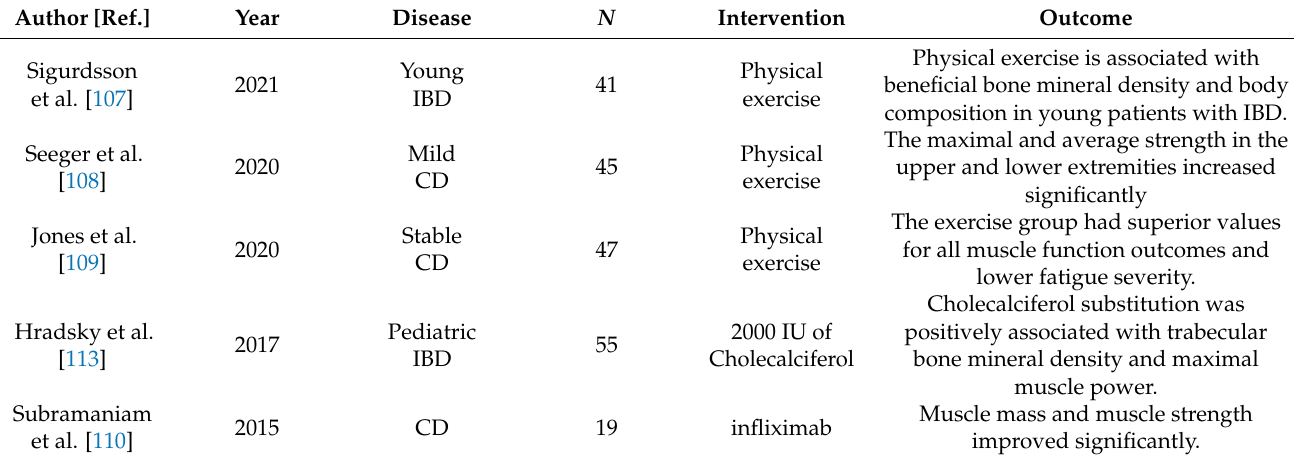
Table 3. The results of interventions for IBD patients focusing on